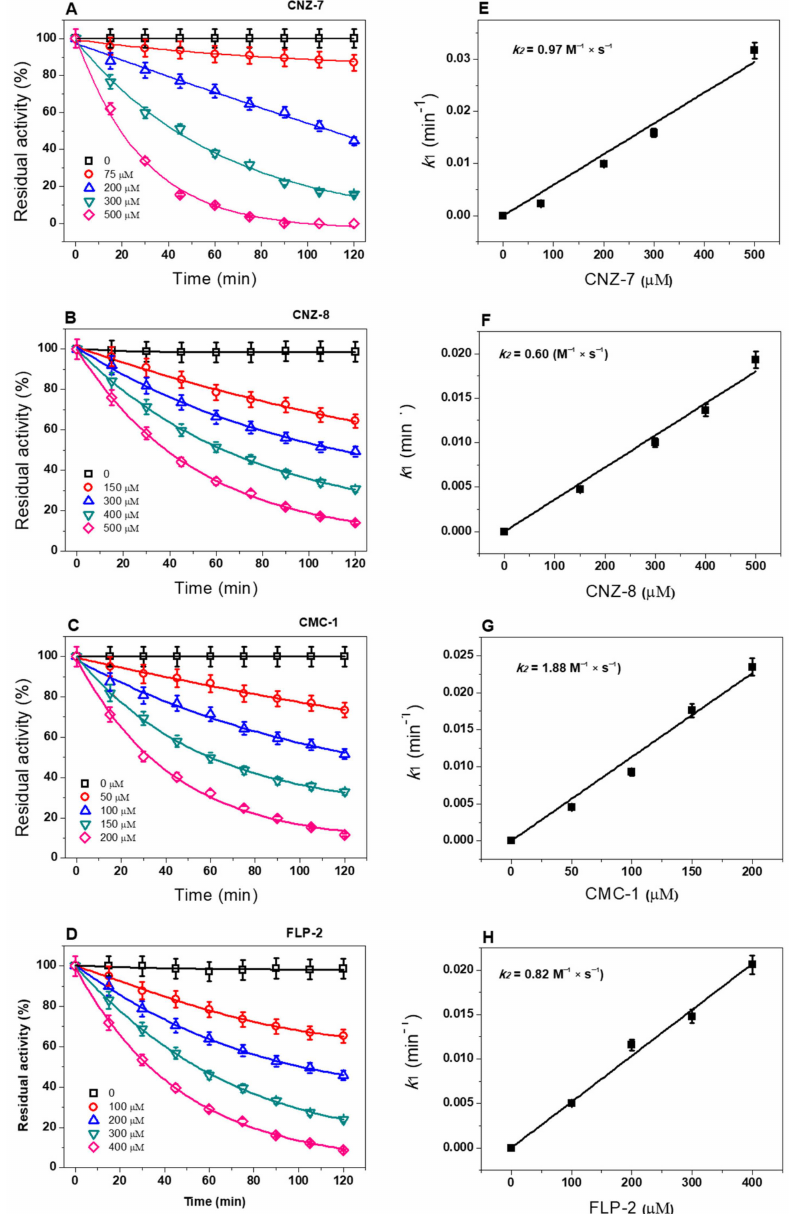
Figure 4. Inactivation of GlG6PD::6PGL by CNZ-7, CNZ-8, CMC-1, and FLP-2 chemical compounds. G6PD::6PGL enzyme was adjusted to 0.2 mg/mL and was incubated with different